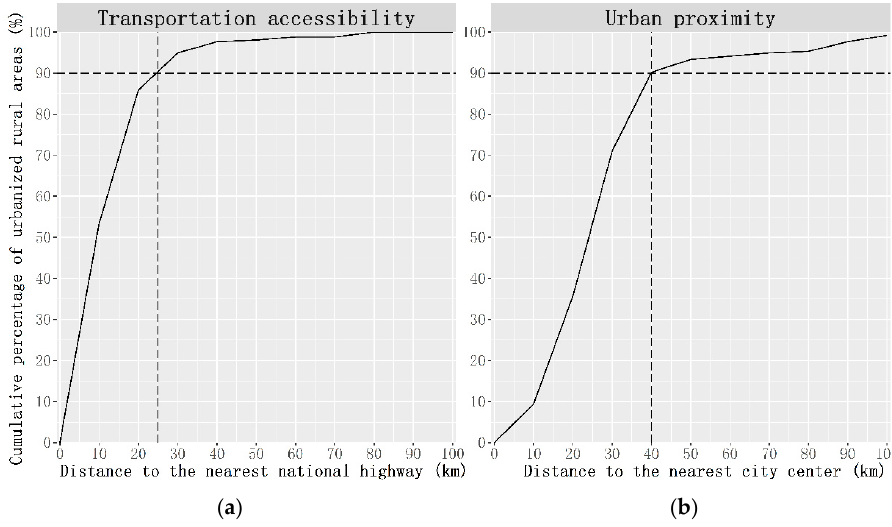
Figure 4. Relationships between transportation accessibility ( a ), urban proximity ( b ), and urbanized rural areas in 2015.